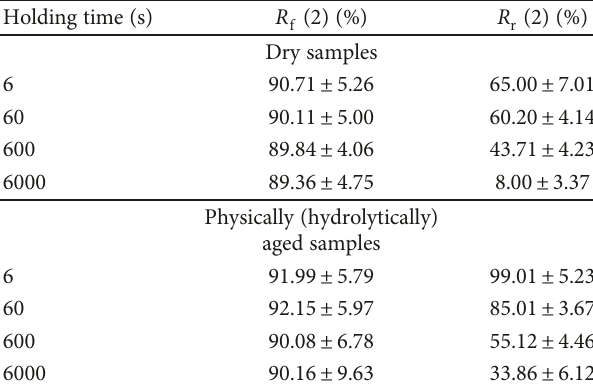
Figure 10: Development of reduced strains of (a) dry- and (b) physically (hydrolytically) aged Estane samples with 3 wt.% water during the recovery process in the 2nd cycle with di ff erent holding times (from 6 to 6000 s) after stretching up to ε thermomechanical tensile test. Achieved shape fi xity ratio of (c) dry- and (d) physically (hydrolytically) aged Estane samples with 3wt.% water after two successive cycles. Results are the average of three similar test runs. The corresponding θ values are plotted as gray lines with respect to the right ordinate. Table 4: Shape-memory properties of dry and physically (hydrolytically) aged Estane programmed at θ = 70 ° C . The results for the fi rst cycle can be found in the Supplement